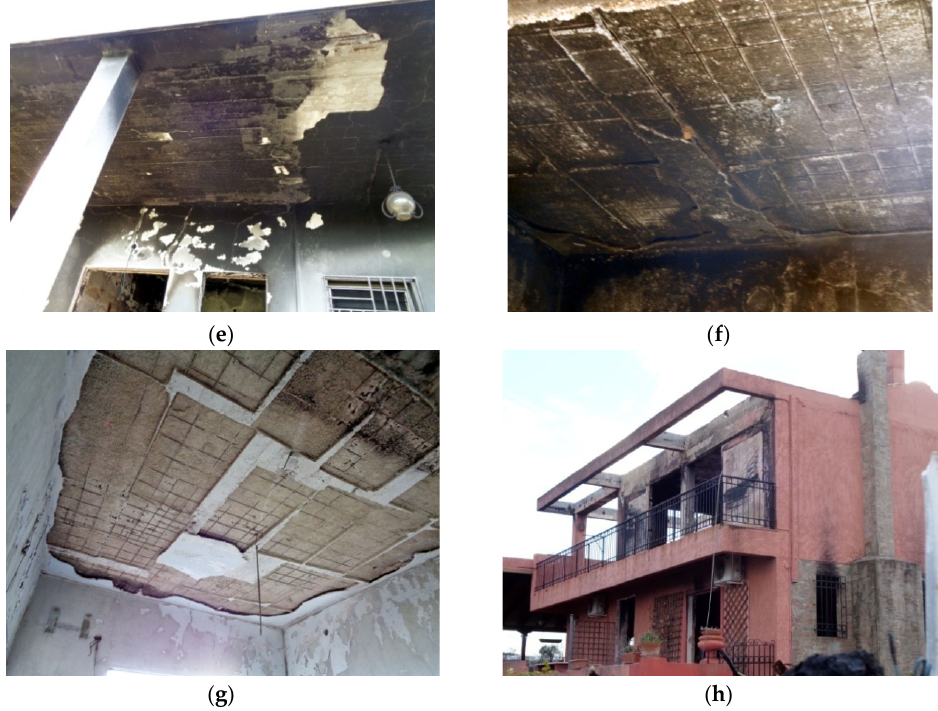
Figure 5. Pictures showing damage that occurred in reinforced concrete frame buildings and infill walls after the wildfire in Mati: (a, h) discoloration around openings; (b, d) cracking on concrete members; (c) sagging of slabs; (e, f, g) spalling of concrete cover.